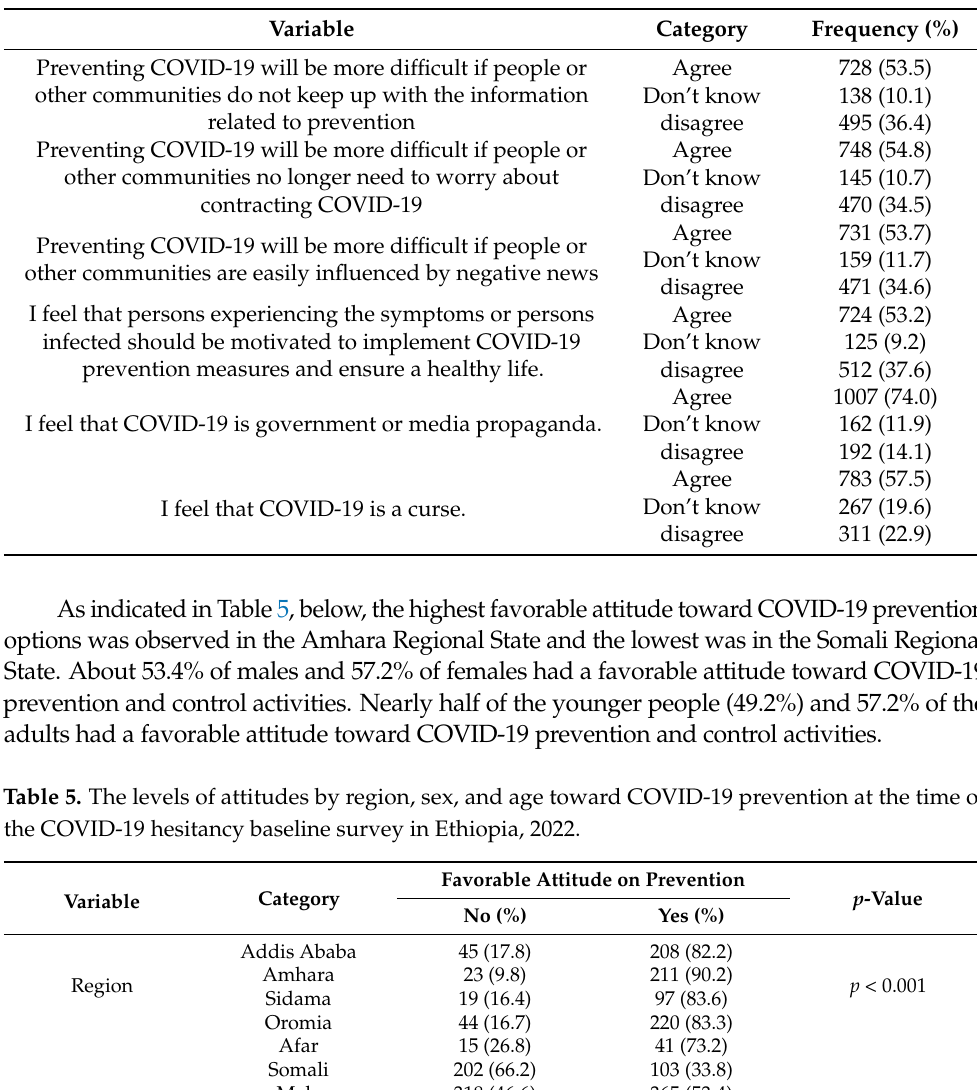
Table 4. Attitudes for each item of the questionnaire about COVID-19 prevention methods at the time of the COVID-19 hesitancy survey, Ethiopia, 2022.